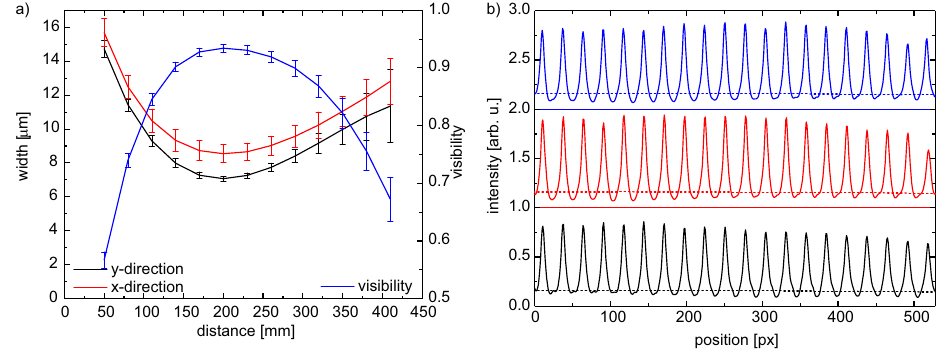
Figure 3. ( a ) Spot sizes for the scanned distance between lens array and detector. The focal distance (average of all 400 spots) is about 200 mm (for 9 keV), defined where spots have the smallest width. The spots have a slightly different width for the x - and y -direction, which arises from different source sizes in horizontal and vertical axis; ( b ) Line plots through three spot rows (red and blue offset shifted), showing the intensity profile in x-direction at a distance of 200 mm as well as the incoming X-ray intensity (dashed